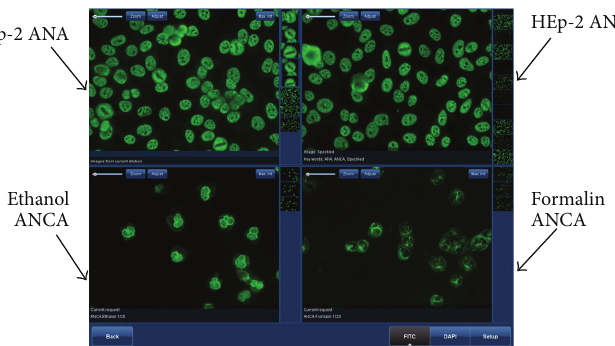
Figure 3: Representative screenshot of a Multianalyte Screen (i.e., QUANTA Link, INOVA Diagnostics Inc.) showing a C-ANCA and speckled ANA double positive sample. Images obtained on ethanol- and formalin-fixed substrates can be displayed next to Hep-2 ANA results simultaneously and thus allow for interpretation with high accuracy. Table 1: Agreement between a new PR3 CLIA assay and an established high sensitivity PR3 assay. Spearman’s rho of results was found at 0.74 (95% CI 0.67–0.80, data not shown) [65]. All patients ( 𝑛 = 196